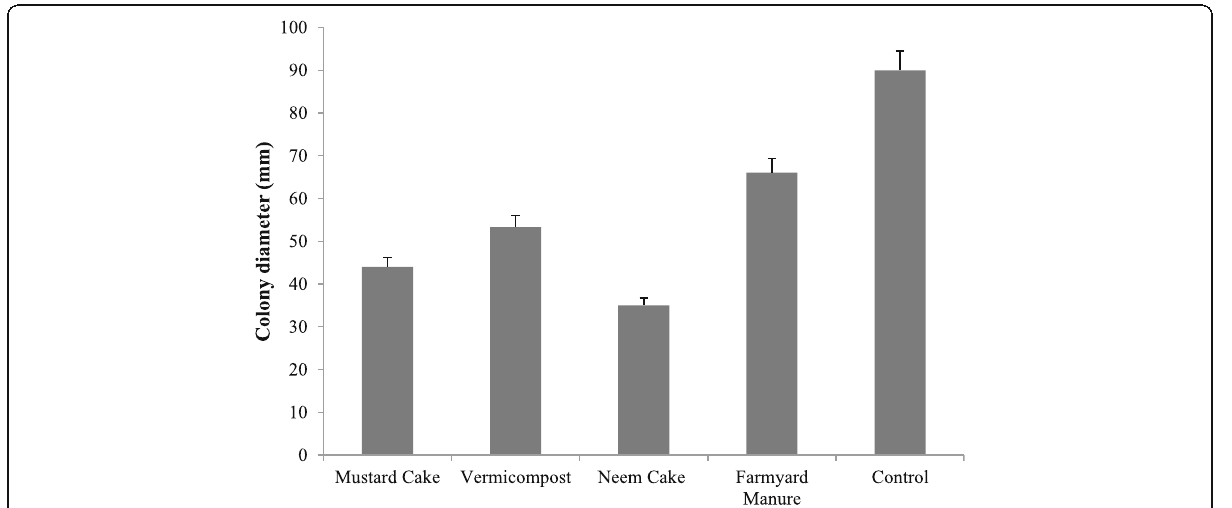
Fig. 2 Effect of the tested organic amendments on the mycelial growth of